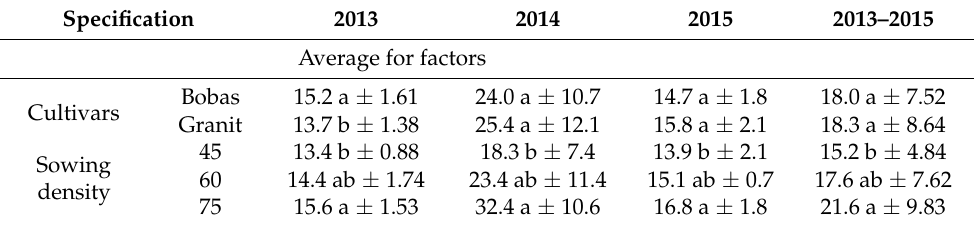
Table 5. Nitrogen accumulation in the faba bean straw (kg ha − 1 ) as influenced by the examined factors during the study years